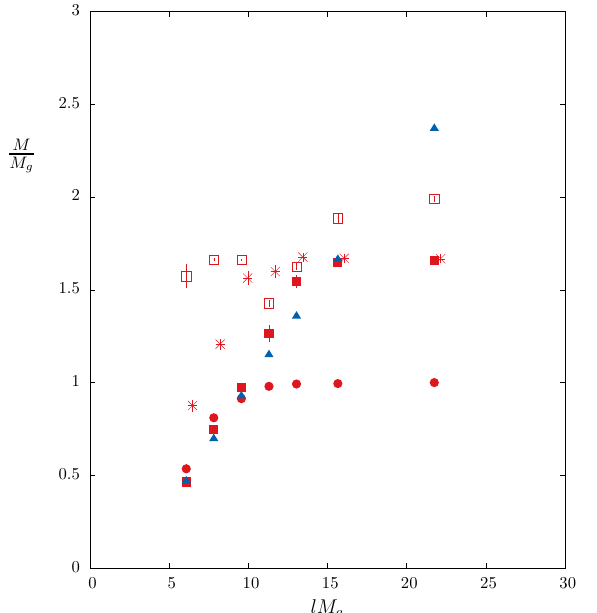
Figure 3 . Lightest J P = 0 + ( (cid:15) ), 2 + ( (cid:4) ) and 2 (cid:0) ( ? ) glueball masses in SU(4) at (cid:12) = 63 : 0 on various spatial volumes, l 2 , all in units of the in(cid:12)nite volume mass gap M g . The 2 (cid:0) has been shifted for clarity. Also shown is the (cid:12)rst excited 2 + ( (cid:3) ) glueball mass and twice the fundamental (cid:13)ux loop energy ( N